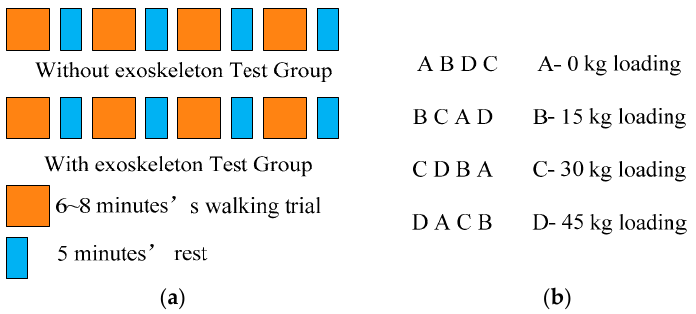
Figure 3. Process of the experiments. ( a ) Testing procedure: the orange square block means 6–8 min walking trial and the blue rectangle means 5 min rest; ( b ) the Latin square arrangement: the capital letters A, B, C, and D are used to represent the load level 0 kg, 15 kg, 30 kg, and 45 kg separately.